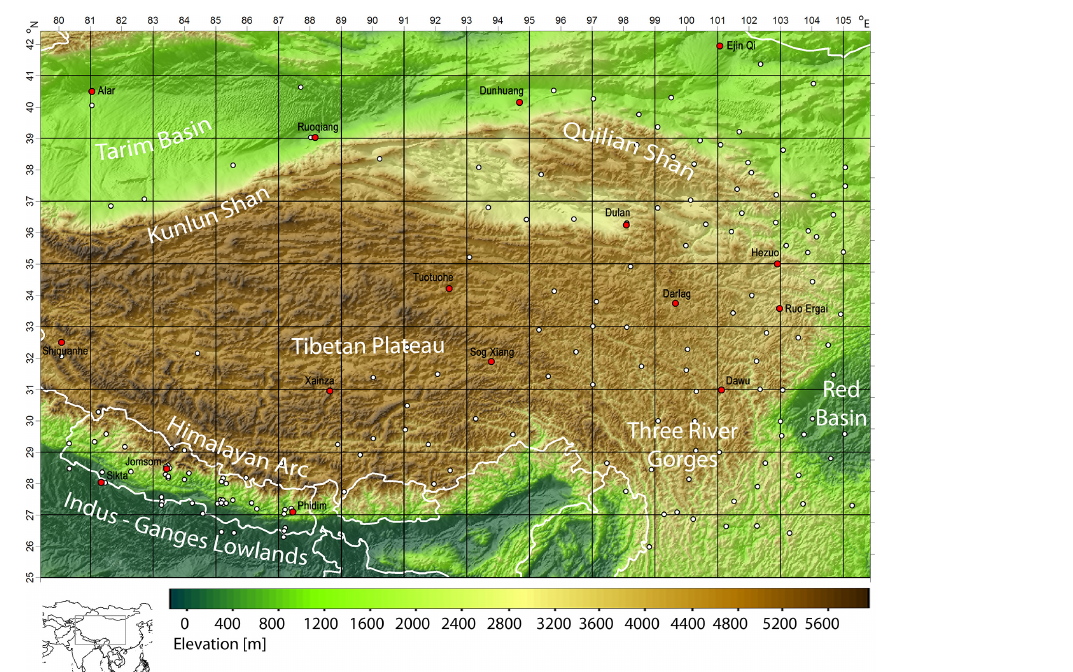
Figure 1. The target area and its main geomorphological features. The white dots indicate the locations of meteorological stations used for the implementation of the statistical downscaling model. The locations marked in red were used for the model